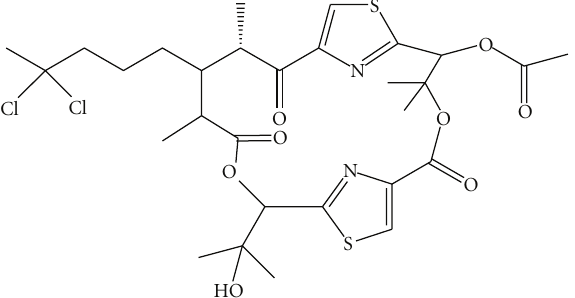
Figure 10: Structure of